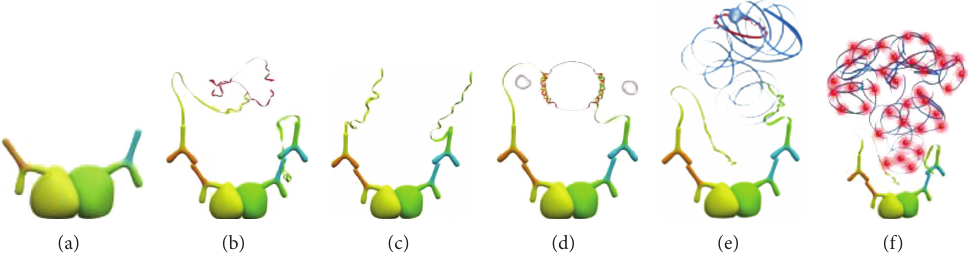
Figure 1: The principle of the Duolink proximity ligation assay. (a) Binding of primary antibodies to PTPIP51 and the IR or PKA. (b) Binding of secondary antibodies, PLA probe PLUS and PLA probe MINUS. (c) Connector oligos only hybridize if both proteins are closer than 40nm. (d) Ligation of the complex forms a circular template. (e) Rolling circle amplification. (f) Amplification yields a some hundredfold replication, and added fluorophore labelled probes highlight the reaction, resulting in a point-shaped signal. Figure 1 is a reproduction of the Olink instruction manual by courtsey of Olink